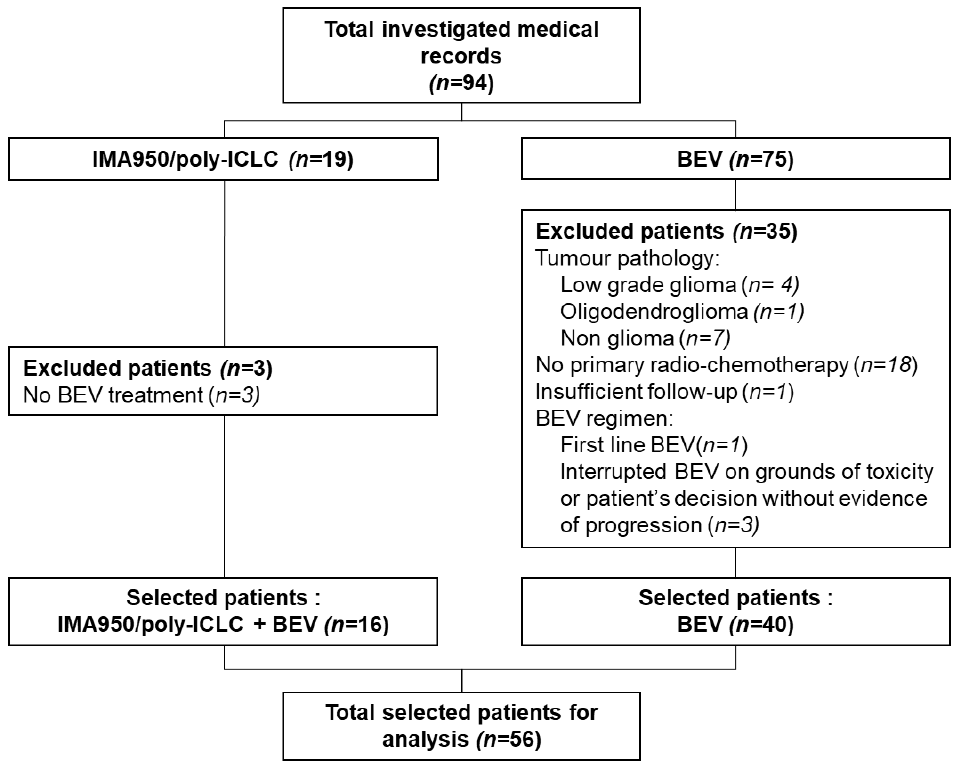
Figure 1. Patient CONSORT diagram. Poly-ICLC, polyinosinic-polycytidylic acid stabilized with polylysine and carboxymethylcellulose; BEV, bevacizumab.